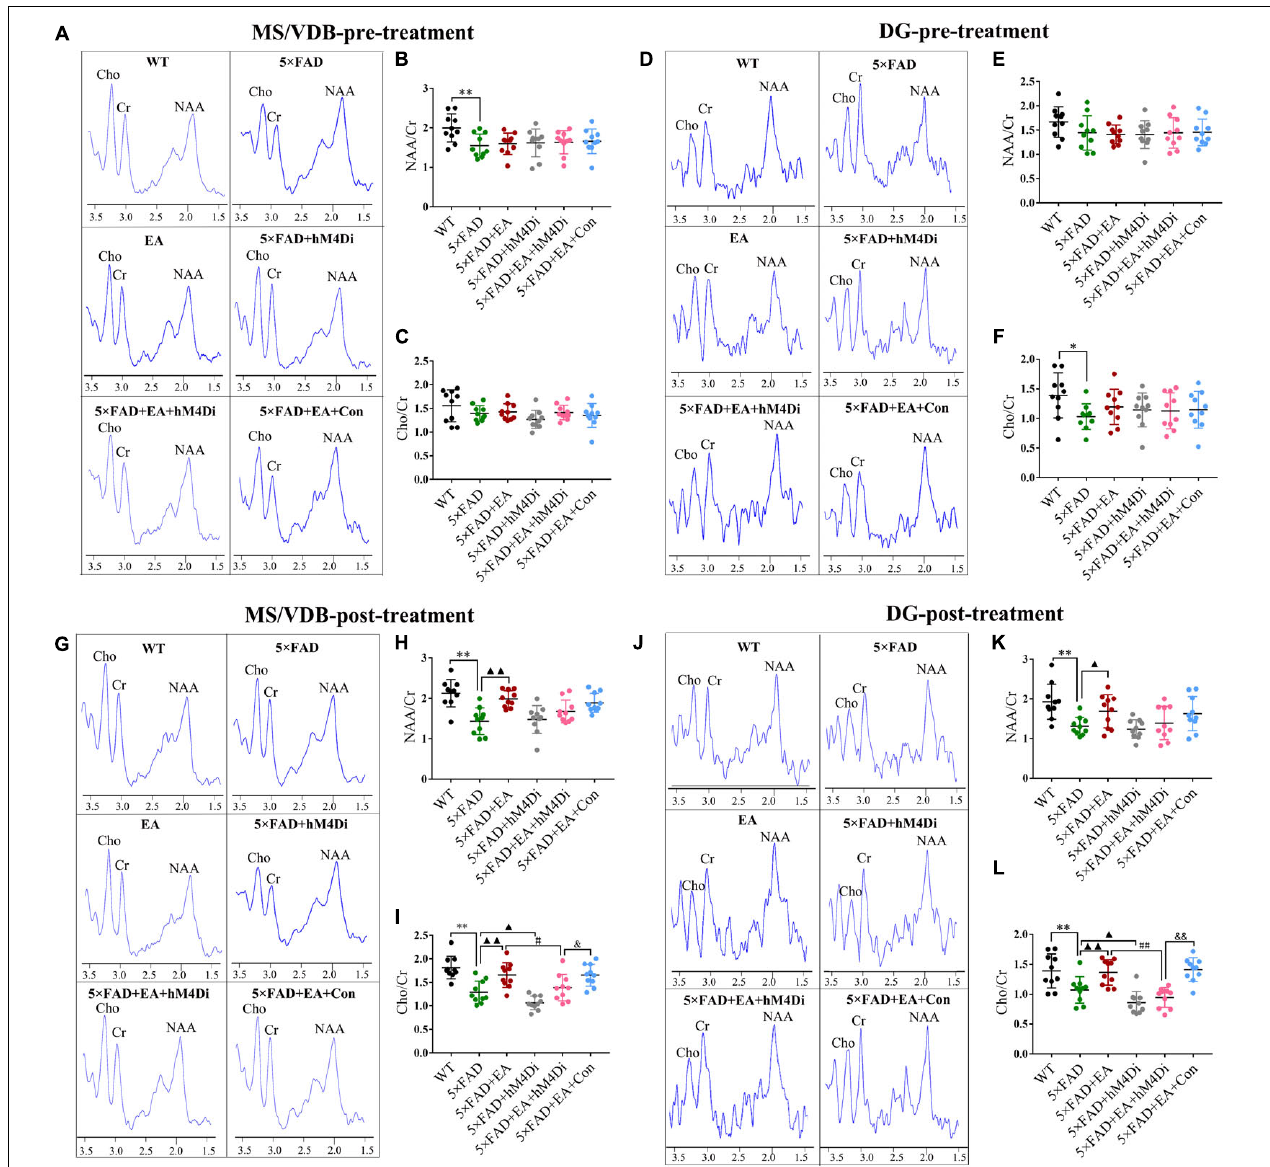
FIGURE 11 | Electro-acupuncture (EA) treatment activates the MS/VDB-DG regulating Cho/Cr in 5 × FAD mice. (A,D,G,J) 1 H MRS exhibits NAA peak at 2.02 ppm, Cho peak at 3.2 ppm, and Cr peak at 3.05 ppm in MS/VDB and DG of groups pre- and post-treatment. The ratio of NAA/Cr in MS/VDB (B,C) and Cho/Cr in DG (E,F) were significantly decreased pre-treatment. The ratios of NAA/Cr and Cho/Cr in MS/VDB (H,I) and DG (K,L) were significantly increased in the 5 × FAD + EA group. With inhibition of the MS/VDB-DG cholinergic neural circuit, the ratios of Cho/Cr in MS/VDB and DG were decreased. Data are represented as mean ± SD, n = 10/group, and each circle represents a mouse ( ∗ p < 0.05 and ∗∗ p < 0.01 vs WT group; (cid:78) p < 0.05 and (cid:78)(cid:78) p < 0.01 vs 5 × FAD group; # p < 0.05 and ## p < 0.01 vs 5 × FAD + EA group; & P < 0.05 and && p < 0.01 vs 5 × FAD + EA + hM4Di group).